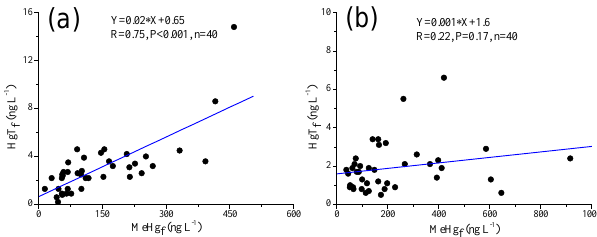
Figure 3. Correlation between HgT f and MeHg f concentrations in soil porewater during the rice growing season on Days 20, 40, 60, and 80: ( a ) artisanal Hg mining site of Gouxi; (b) abandoned Hg mining site of